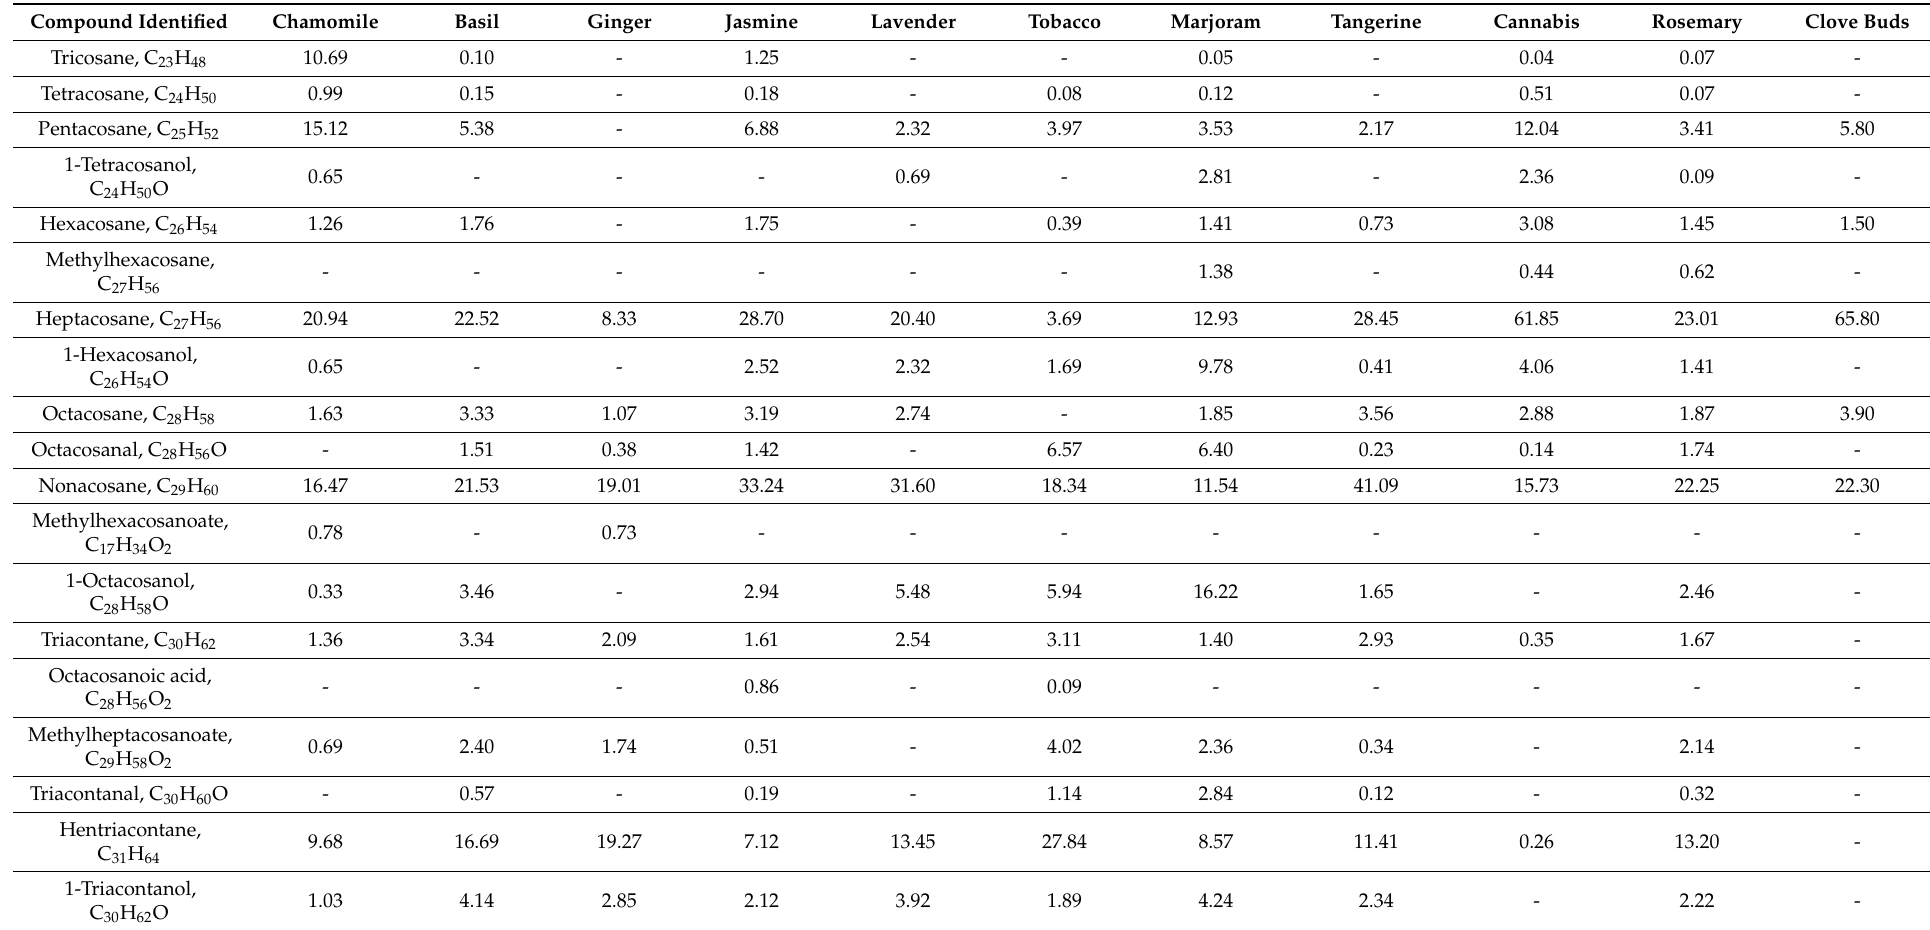
Table 1. Percentage (area %) of the compounds identified by GC − MS of cuticular waxes extracted by SC − CO 2 plus fractional separation from different vegetable matter, studied in this